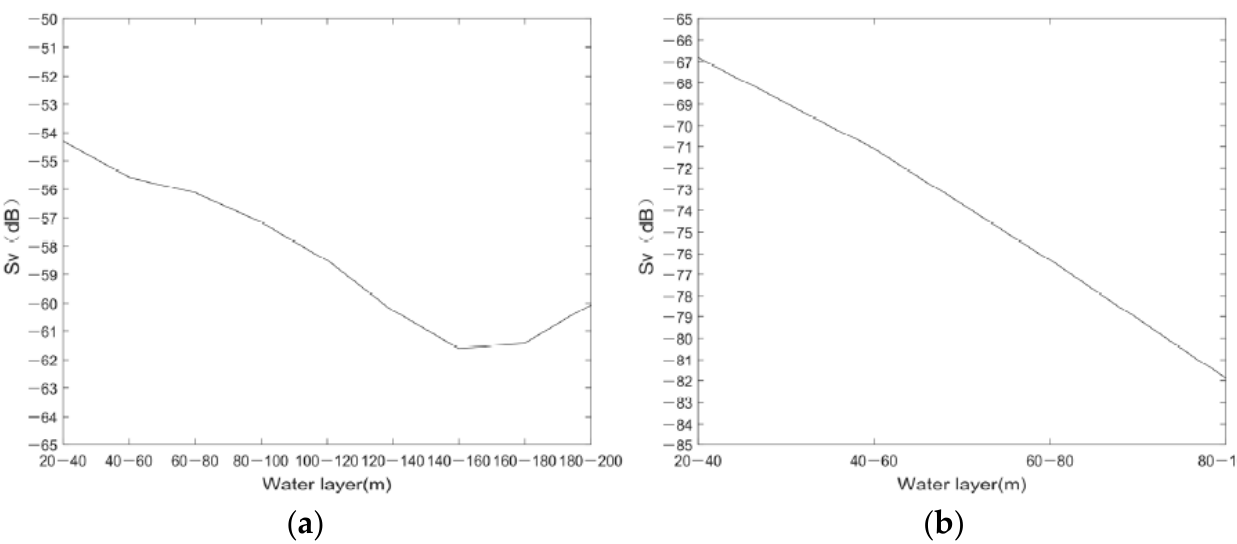
Figure 5. The mean S V values of each layer at the survey area: ( a ) mean S V values without Stations 24, 30, and 31; ( b ) mean Figure 5. The mean 𝑆 values of each layer at the survey area: ( a ) mean 𝑆 𝑉 S V values at Stations 24, 30, and 24, 30, and 31; ( b ) mean 𝑆 values at Stations 24, 30, and 31. 𝑉